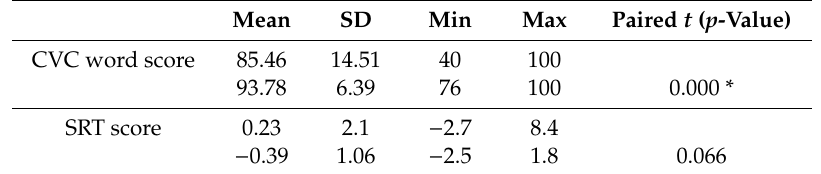
Table 8. Objective speech perception scores for CVC Words and Speech Reception Thresholds (SRT) ( n = 37). Mean SD